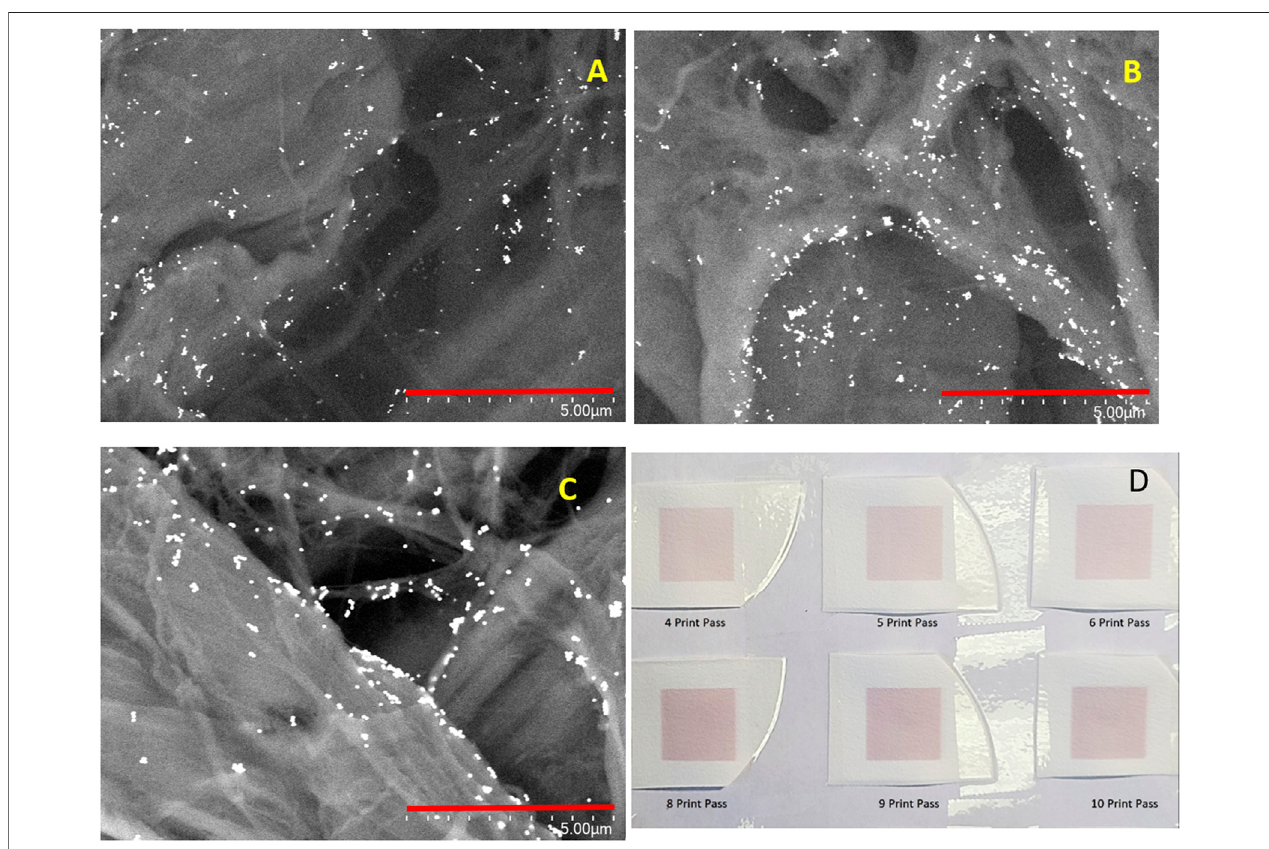
FIGURE2| SEM images ofSERS sensors printed with (A) .50 nm AuNPand 6-printing passes; (B) 50 nm AuNP and 8-printing passesand (C) 80 nm AuNPand 8-printing passes. The scale bar is 5 µm in length. (D) A photograph of the printed SERS sensors with 4, 5, 6, 8, 9 and 10 printing passes.